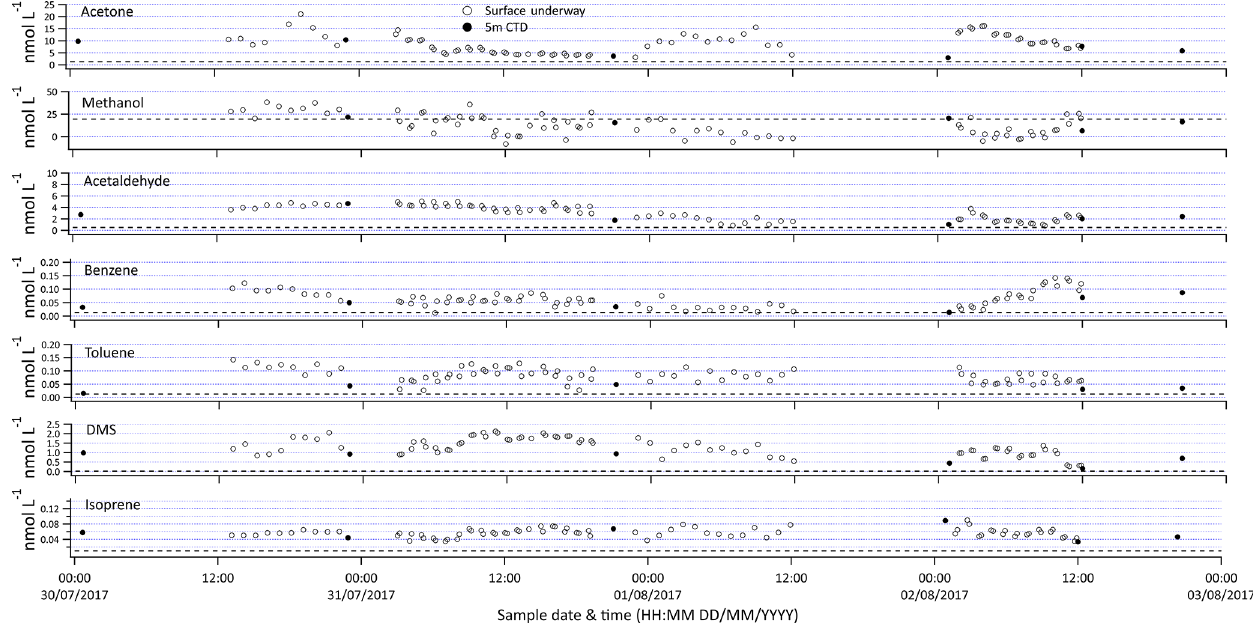
Figure 7. Selection of VOC measurements made from the ship’s built-in underway surface water supply (open symbols) and discrete samples from 5m rosette (closed symbols). The dotted line represents the limit of